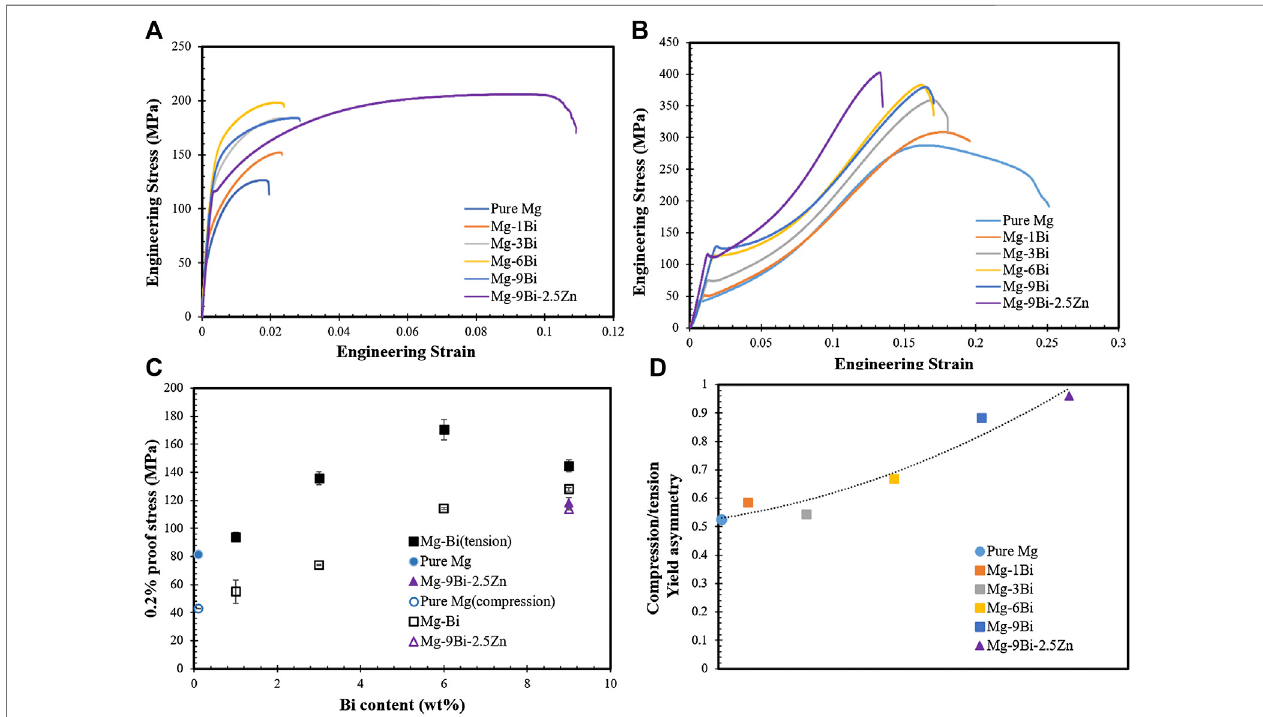
FIGURE 10 | Engineering stress-strain curve of (A) tensile, (B) compression tests, (C) summary of 0.2% offset proof stress, and (D) compression/tension yield asymmetry ratio in alloys studied in present work. The dashed line is used for guiding the eyes.